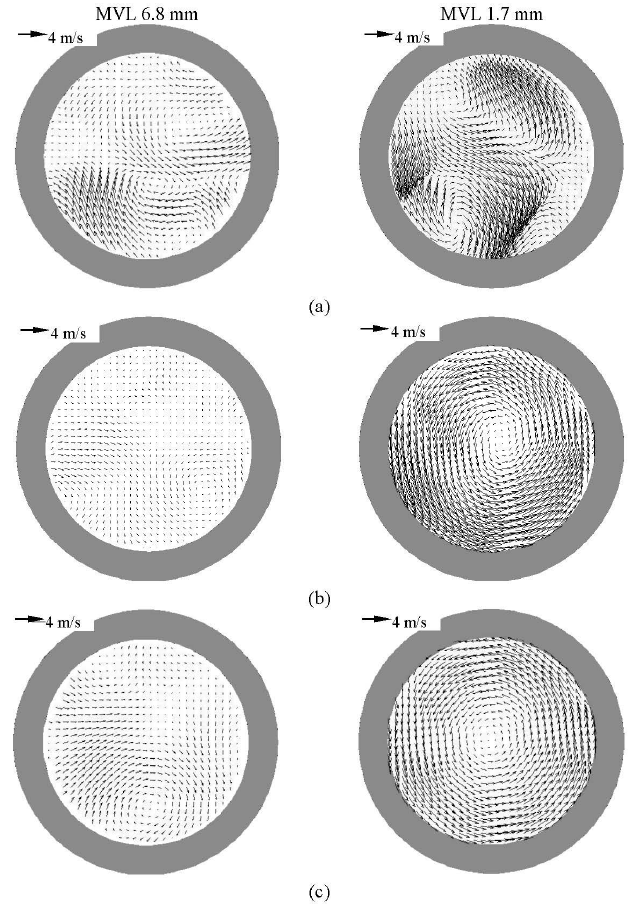
Figure 7. Swirl flow ensemble-averaged flow fields at the horizontal plane of 5 mm under TDC for MVL 6.8 mm and MVL 1.7 mm. ( a ) At 120 °CA (close to the maximum valve open); ( b ) at 240 °CA (close to the valve close); ( c ) at 300 °CA (close to the compression end). CA: crank angle.